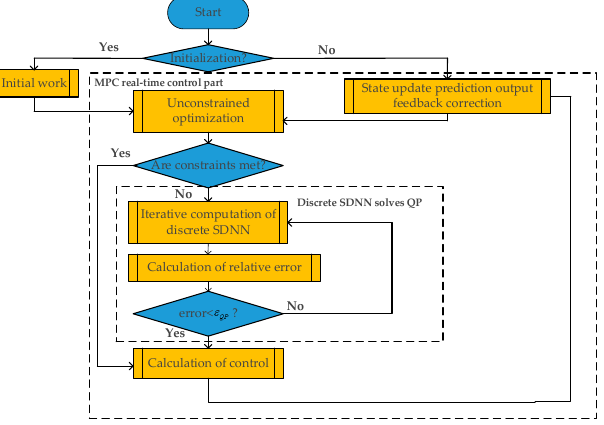
Figure 7. Flow chart of DMPC algorithm.